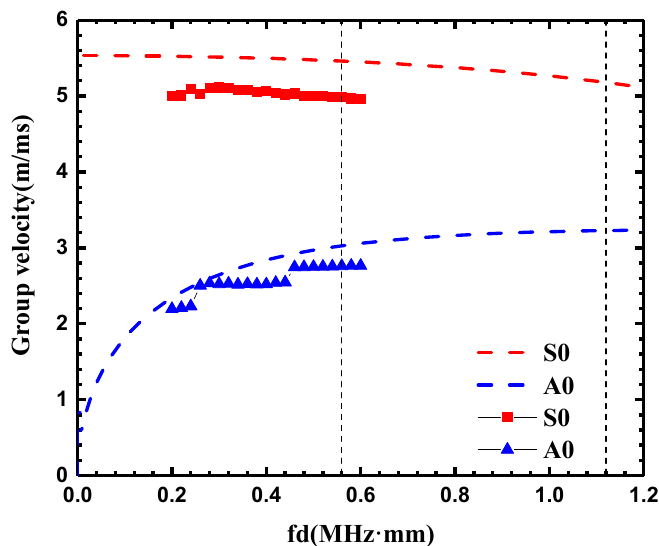
Figure 4. Comparison of experimental data ( ■ and ▲ ) and calculated dispersion curves for a 2 mm thick plate (red dashed line shows S0 mode and blue dashed line shows A0 mode).